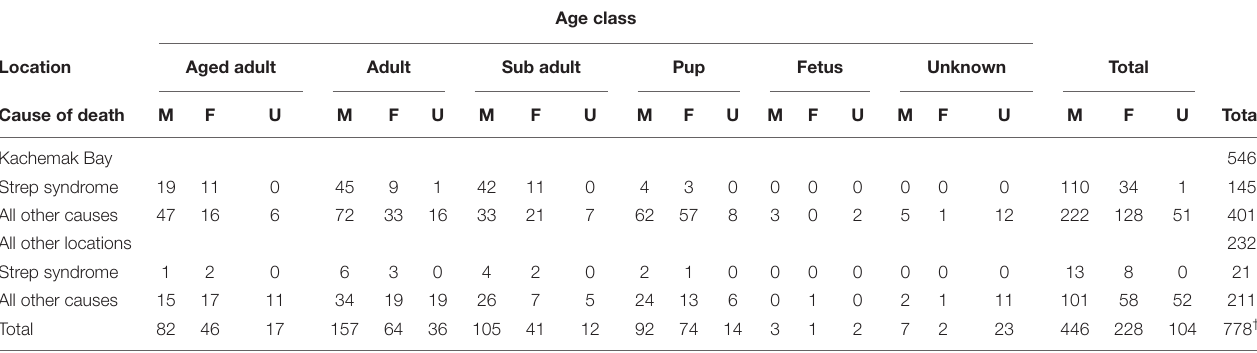
TABLE 1 | Northern sea otter ( Enhydra lutris kenyoni ) carcasses by location (Kachemak Bay vs. all other locations) and cause of death ( Strep syndrome vs. all other causes) by age class in Alaska from 2002 to